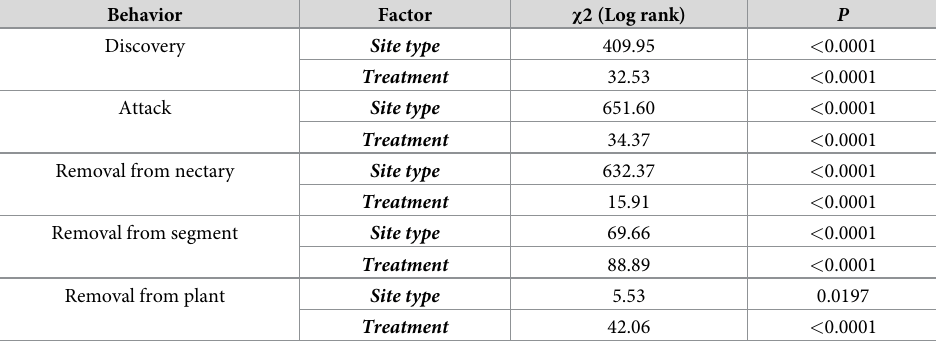
Table 2. Results from K-M survival analysis of the times it took ants to perform behaviors associated with defend- ing C . imbricata plants. Behavior